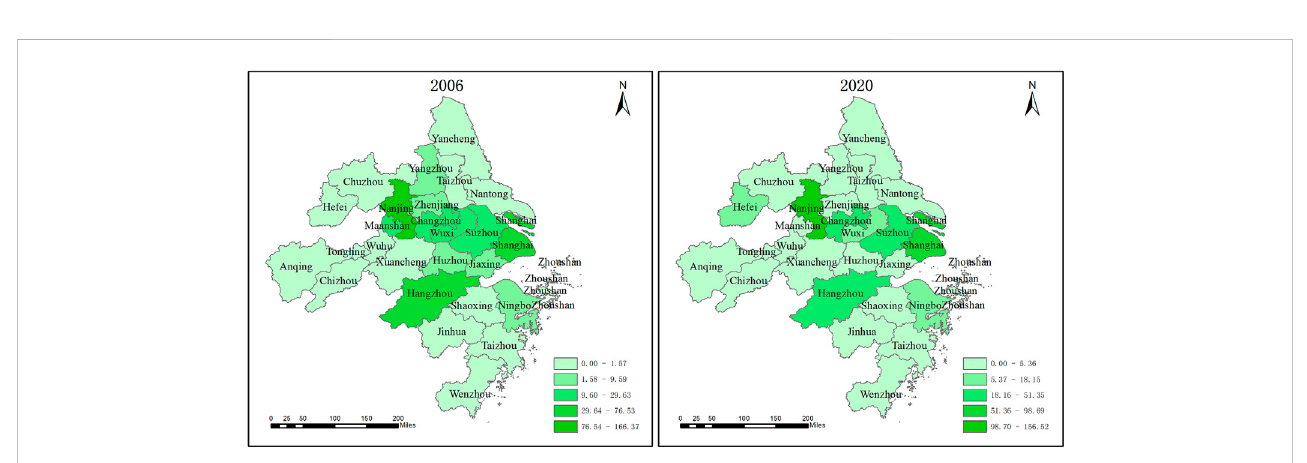
FIGURE 8 The betweenness centrality of 2006 and 2020 in Yangtze River Delta city